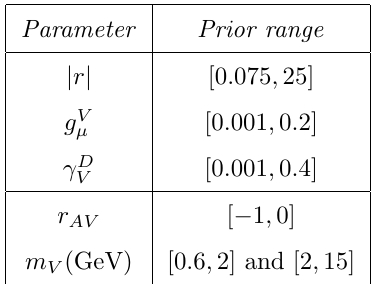
Table 1 . Prior ranges for the free parameters of the model. For the (cid:12)rst three parameters the prior distribution is given in logarithmic scale, while for the others it is given in linear